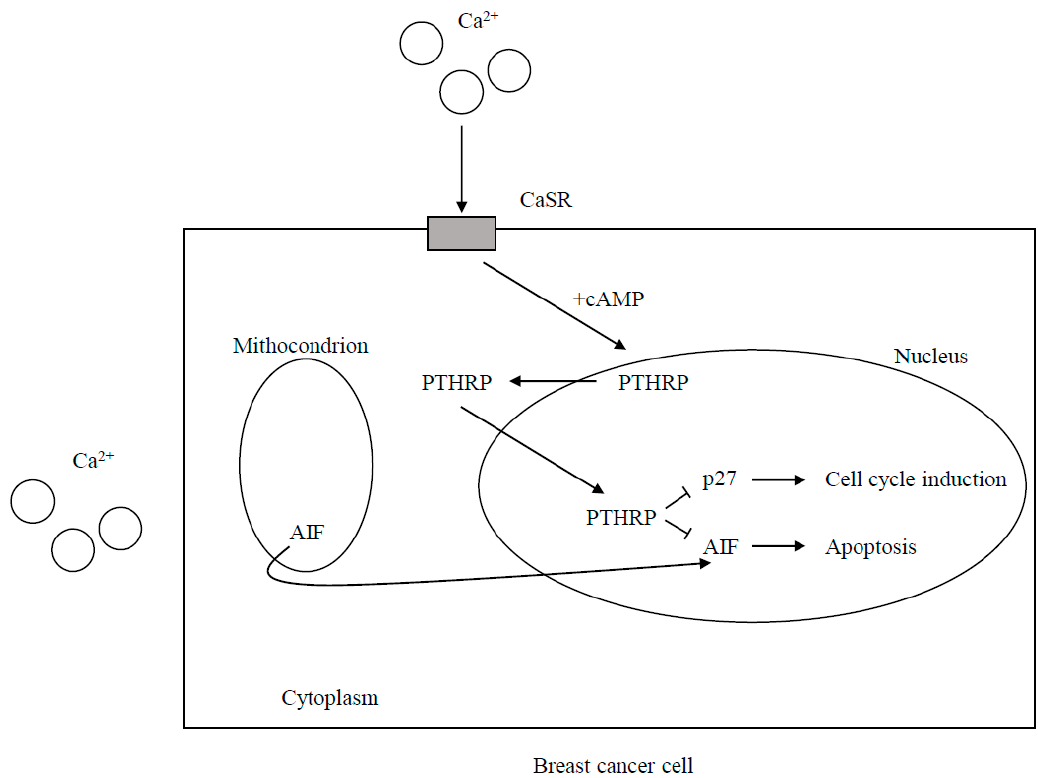
Figure 1. Calcium sensing receptor (CaSR)-nuclear PTHRP pathway. CaSR activation through cAMP levels increases PTHRP production. The increased PTHRP at nuclear level decreases the expression of cell cycle inhibitor p27 kip1 and inhibits accumulation of apoptosis activator AIF (apoptosis inducing factor). Therefore, proliferation and cell survival are promoted (also see text).